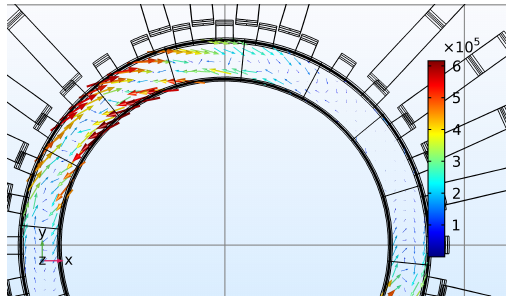
Figure 12. Current density in the PM ring @ 2300 rpm, n seg = 4 at t = 0.68 ms.